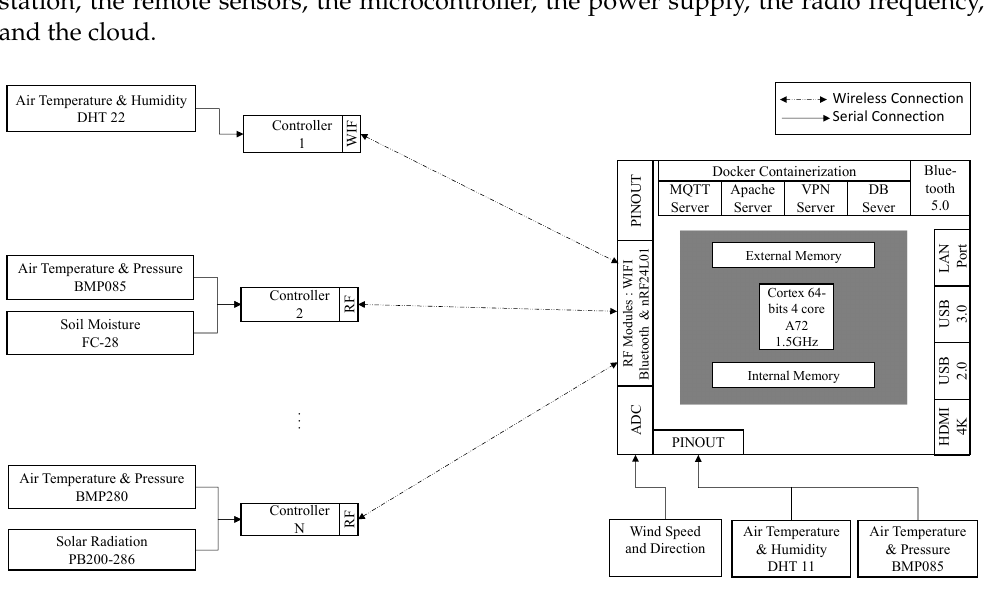
Figure 4. The high level block diagram of the agro-weather